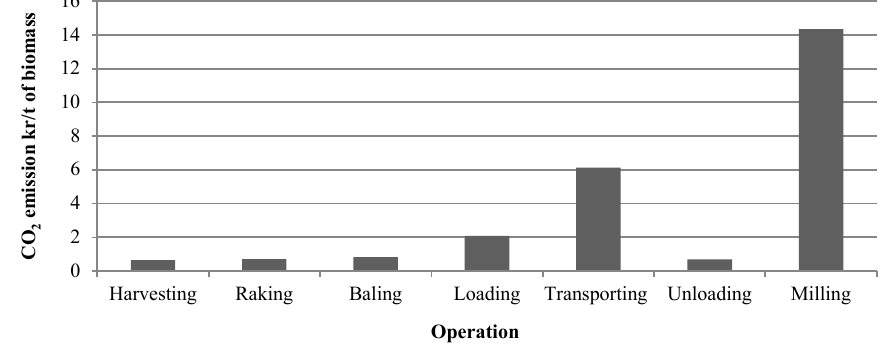
Fig. 5. The structure of CO 2 emission from fossil fuel (Technology “A”).